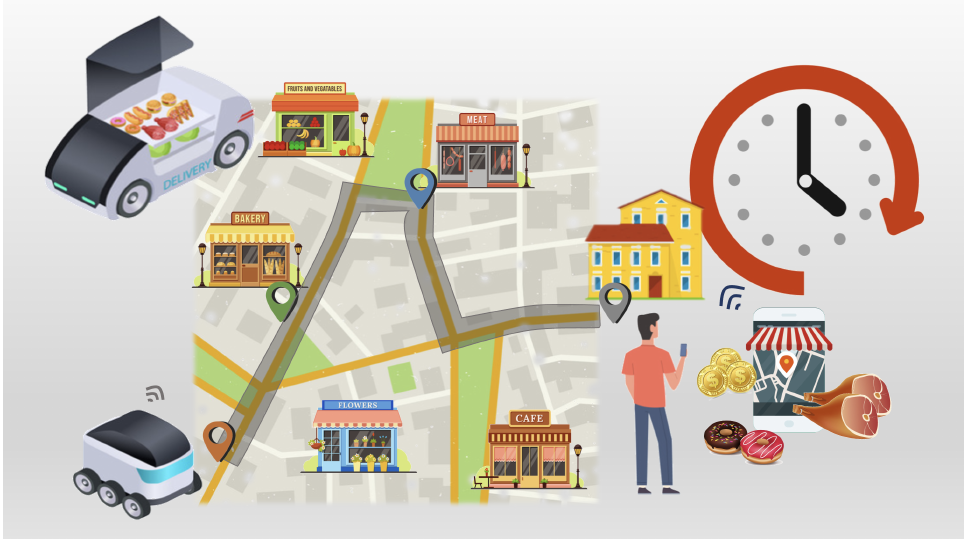
Figure 1. The conceptual representation of the driverless delivery in last